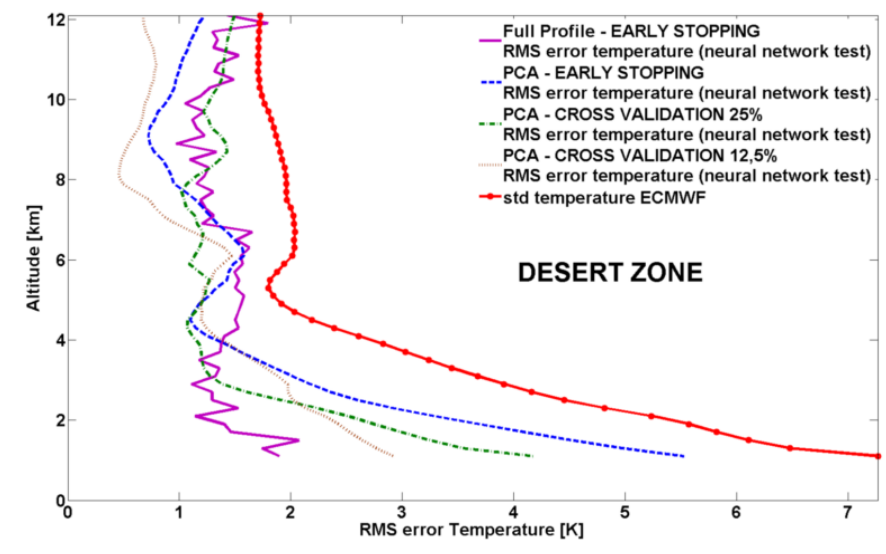
Figure 4. Desert zone, neural network independent test (10 occultations): RMS error profiles for T using the different neural network approaches.